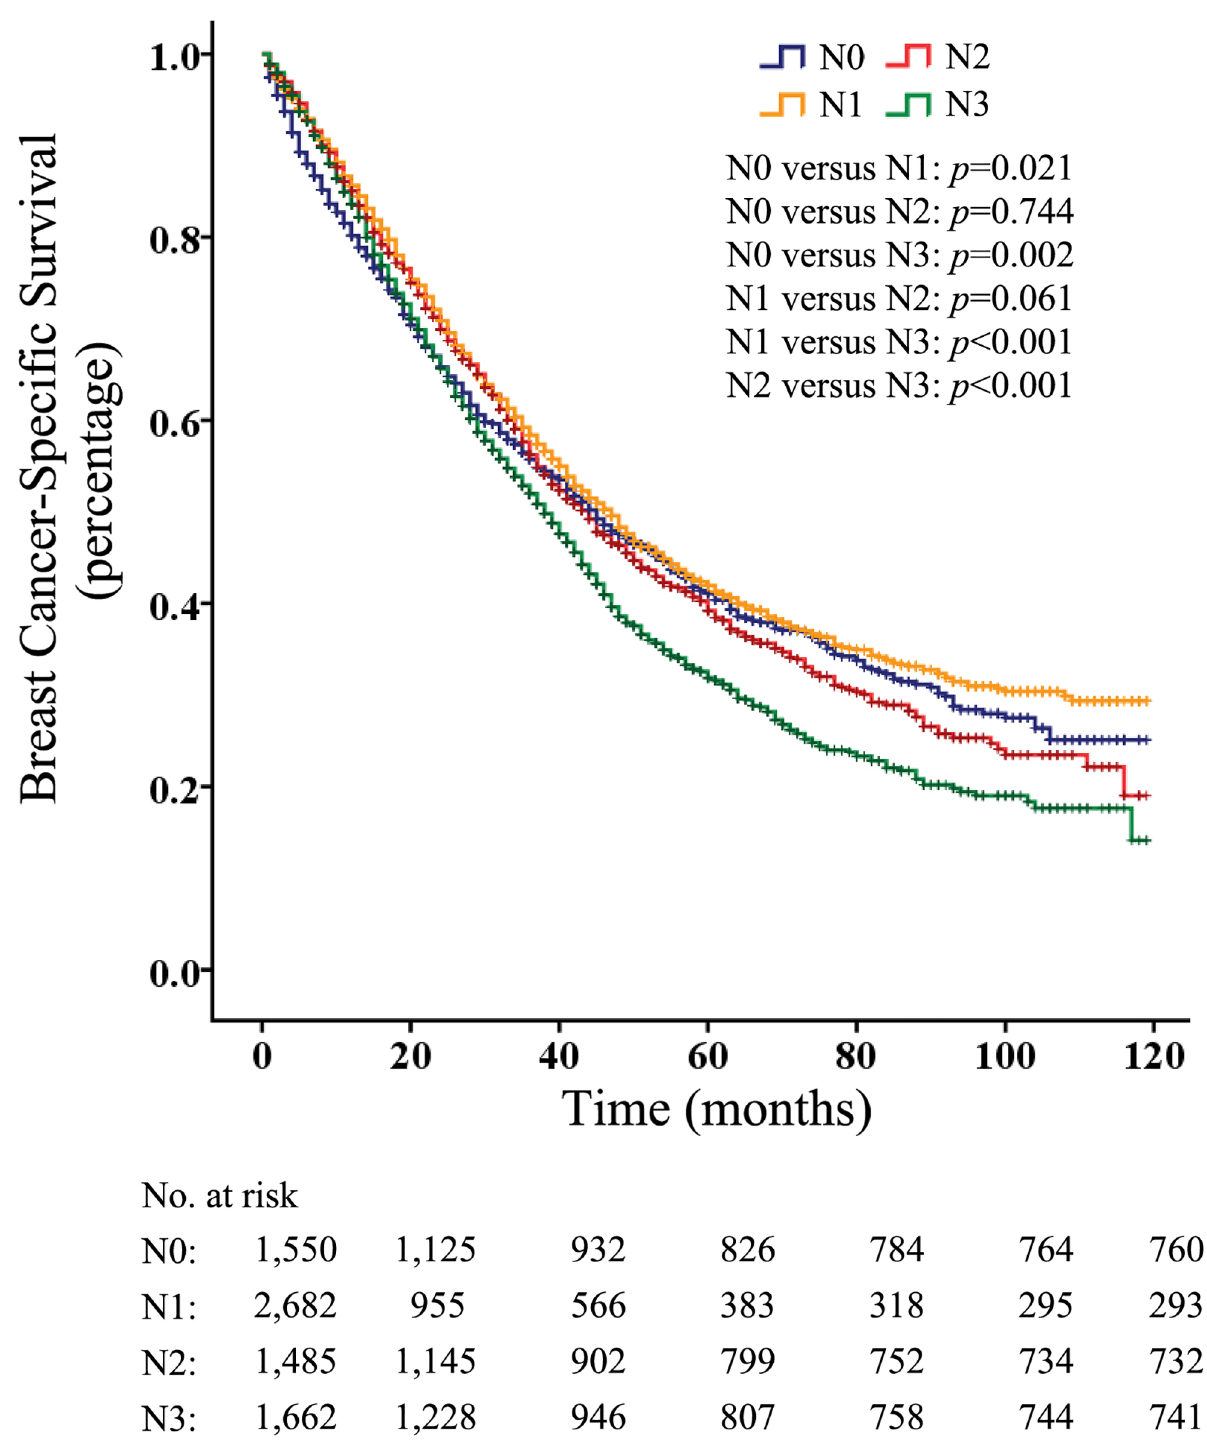
Fig 2. Breastcancer–specific survival according to N categories in patients with M1 Disease.